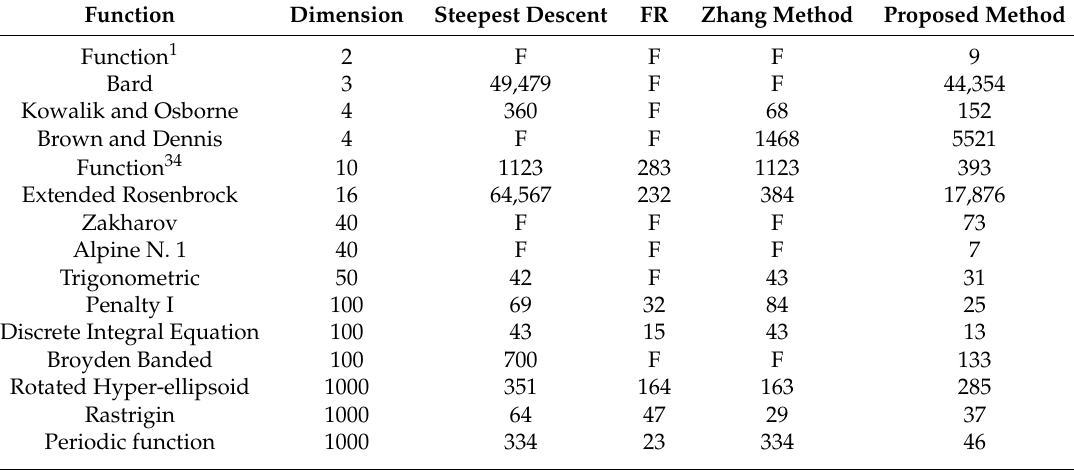
Table 3. The number of function evaluations (Nf) for different